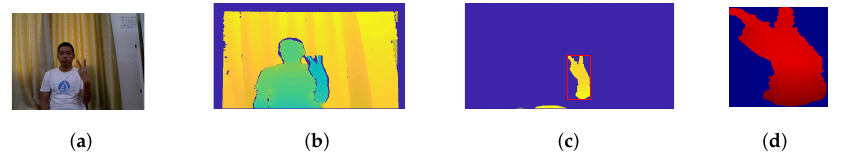
Figure 2. Simulation result of preprocessing step on HUST-ASL dataset: ( a ) Color image of the RGB-D images. ( b ) Depth map of the corresponding color image. ( c ) Localization of hand from the depth map using depth thresholding and removal of noise. ( d ) Resize of the hand segmented image according to pre-trained CNN input